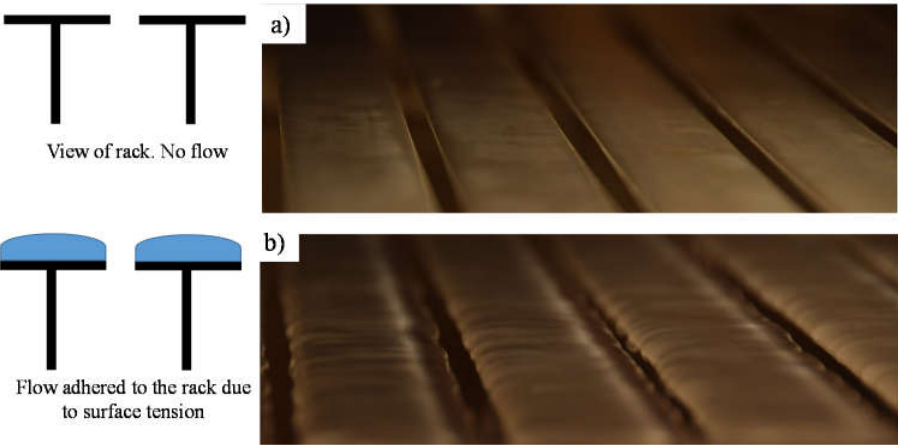
Figure 1. View of the final section of the bottom rack with T-shaped bars with void ratio m = 0.16 and spacing between bars of 5.7 mm in two different cases: ( a ) no flow; ( b ) flow adhered to the rack due to surface tension.